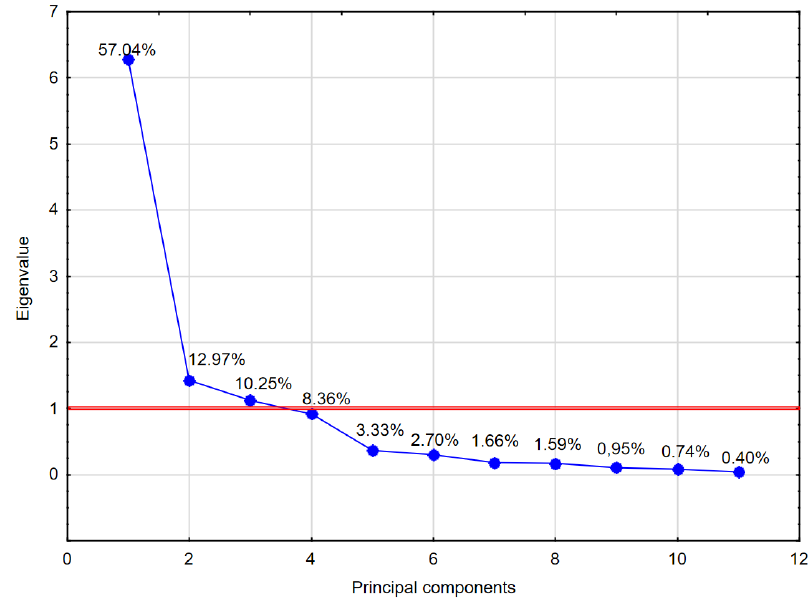
Figure 4. A scatter plot in exploratory factor analysis. Table 6. The value of the coefficients for the principal components.